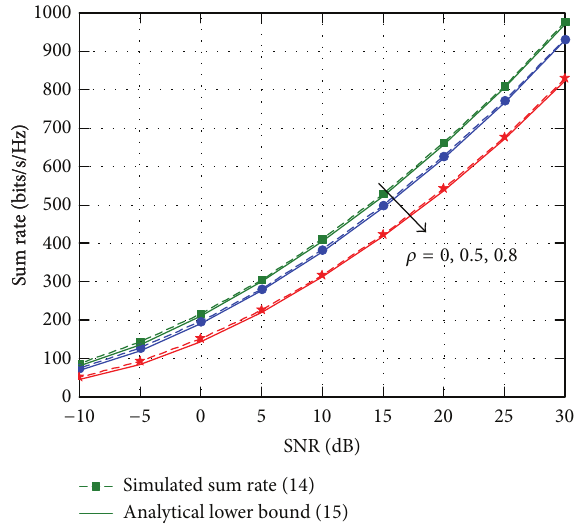
Figure 3: Simulate sum rate and lower bound against the SNR 𝛾 (𝑁